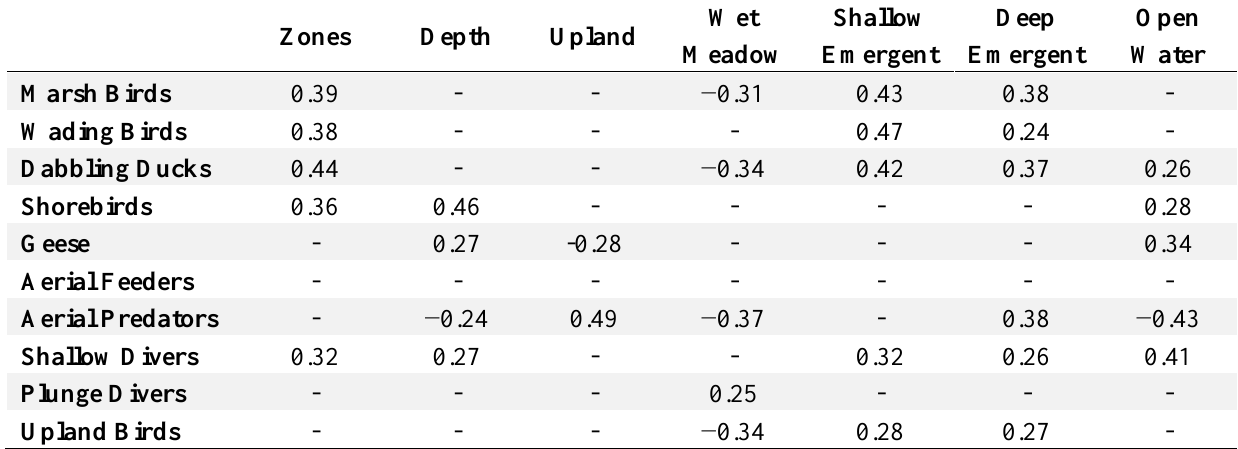
Table 6. Spearman Rank Order correlation coefficients among avian guilds and habitat characteristics surveyed in 2008 and 2009. Correlation coefficients shown are significant at p =